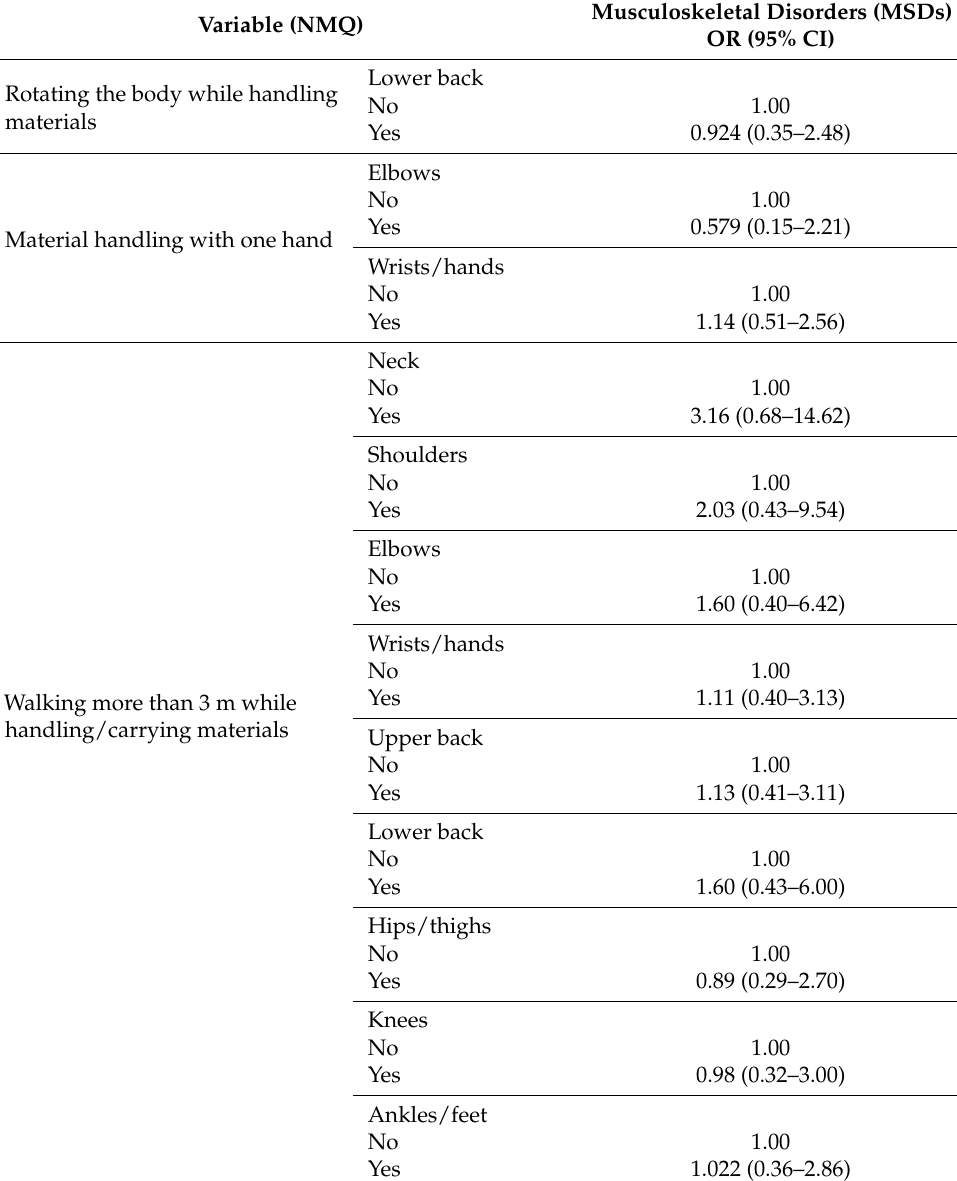
Table 5. Hazard ratio analysis between the NMQ and scale III of the checklist for